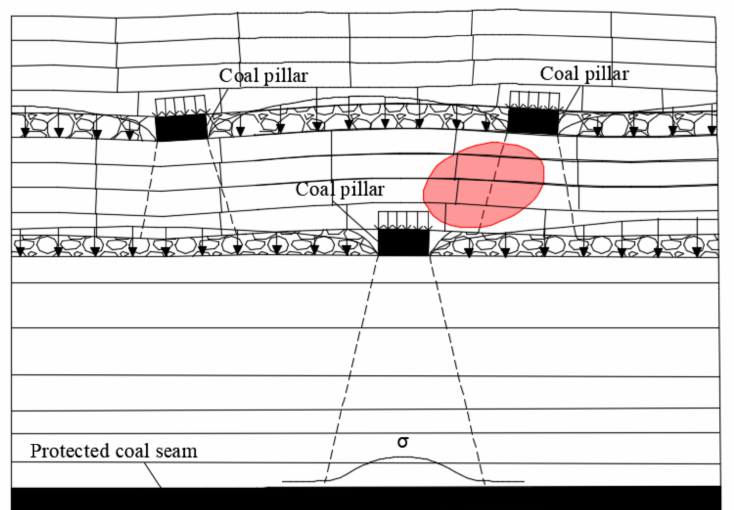
Figure 7. Stress system distribution of the protective layer under the influence of the coal pillar.